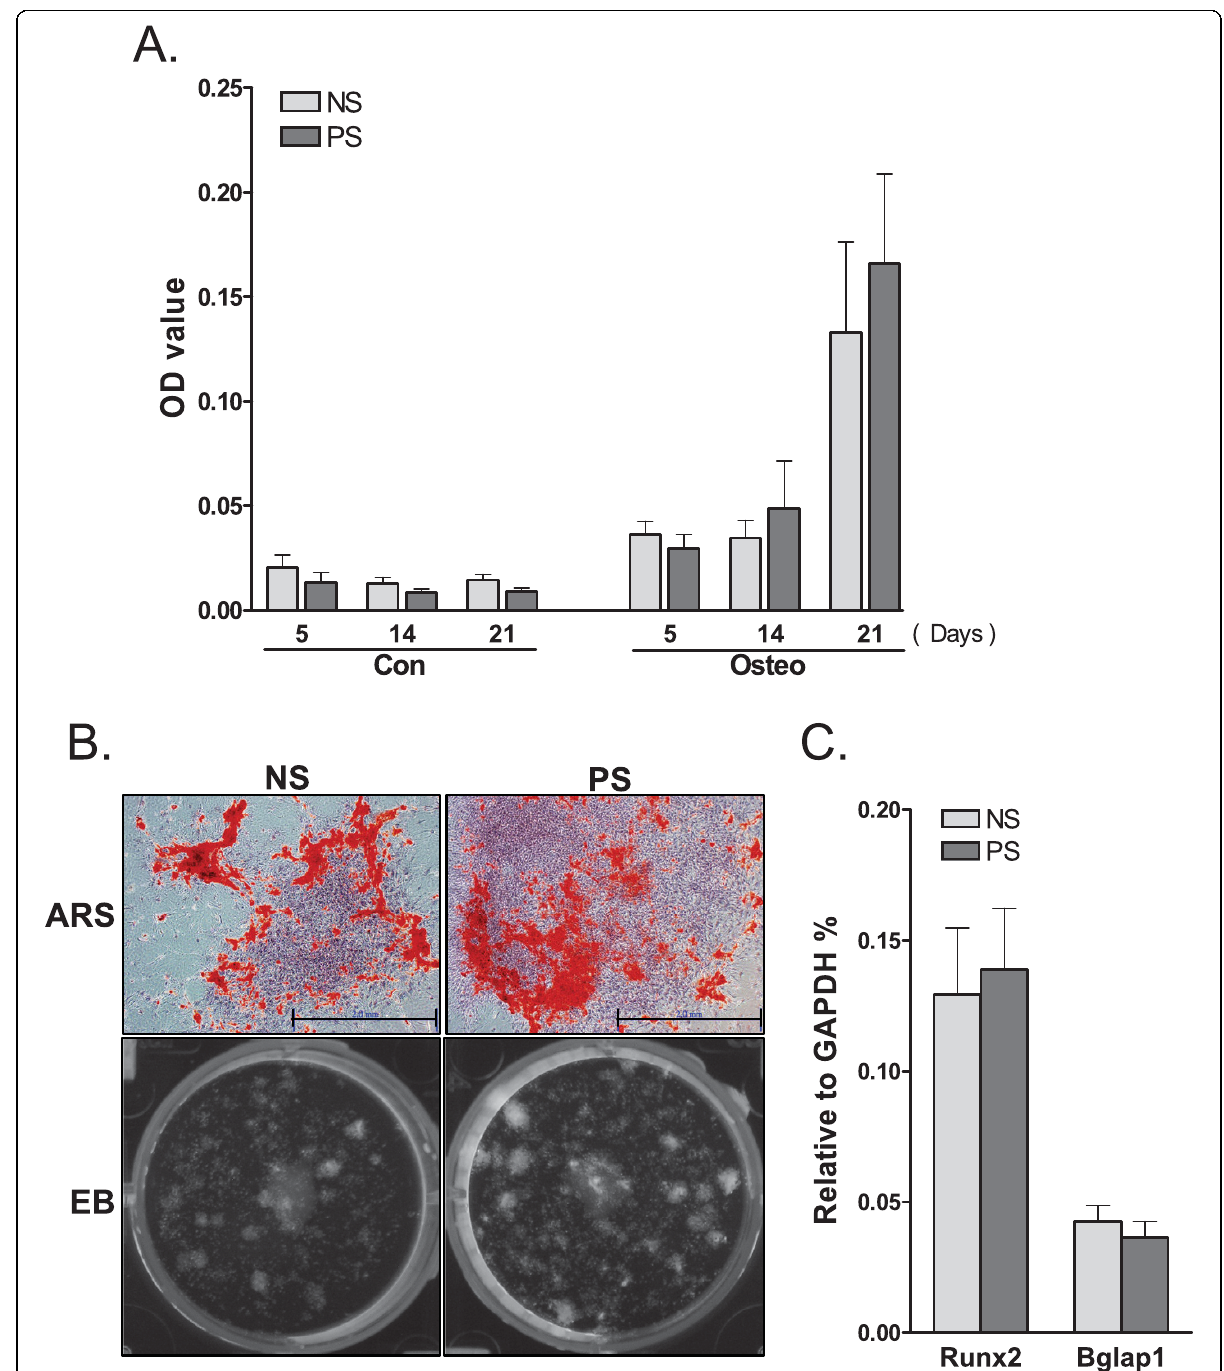
Figure 5 Pre-strain does not enhance osteogenic differentiation in adult ADSCs . A . The extracted ARS stain normalized to the DNA content of adult ADSCs which were either pre-strained or unstrained, followed by osteogenic induction for 5, 14, or 21 days. A gradual increase in ARS stain was found following osteogenic induction, but no significant difference between the pre-strain and non-strain groups was found. N = 6. B . ARS staining of osteogenic colonies (day 14) of adult ADSCs with or without pre-strain. Scale bars = 2.0 mm. Ethidium bromide (EB) staining of the same well is shown below. White pixels in the culture well represent positive EB staining and the pre-strained ADSCs formed more colonies than non-strained ADSCs. C . Expression of Runx2 and Bglap1 in pre-strained or non-strained adult ADSCs after 14 days of osteogenesis. No significant difference was found between pre-strained and non-strained samples. N =